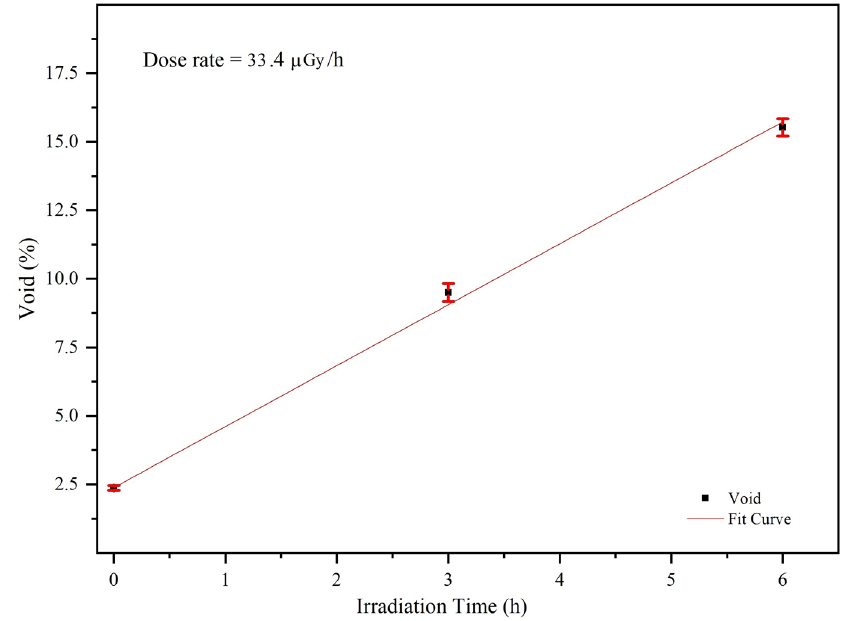
Figure 8. Void percentage in SiO 2 as a function of irradiation time.